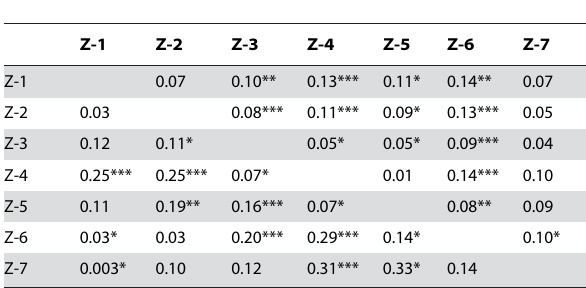
Table 5. Pairwise estimates of multilocus R ST (below diagonal) and F ST (above diagonal) for T. infestans from 7 households in Zurima.